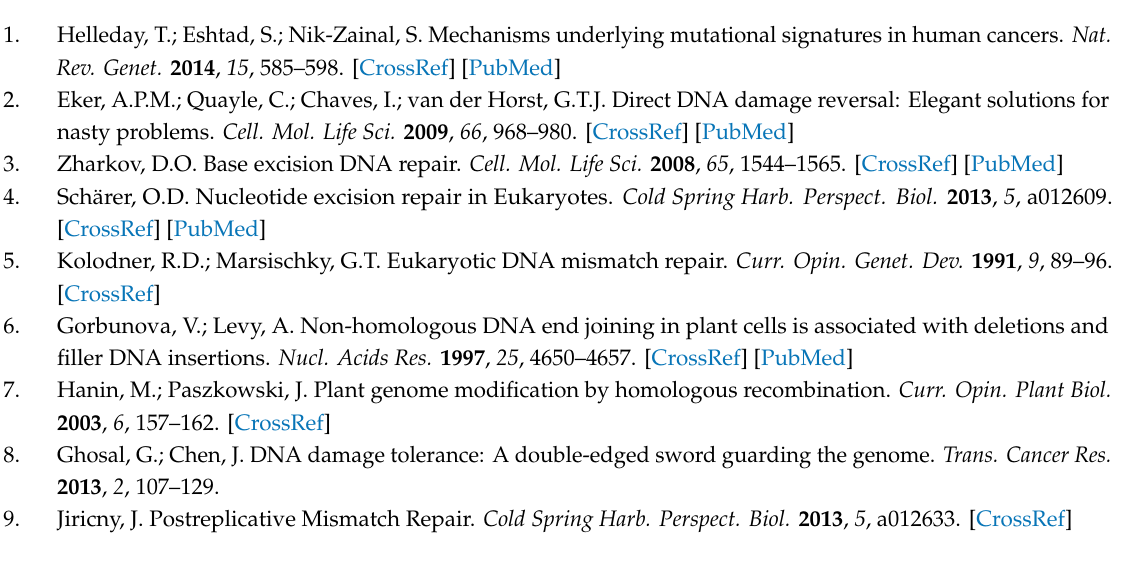
DMC1: wheat. Figure S6: MSH5 interactions. Single MSH5 is shown on the left in purple and interaction is on the right. Interactions from top to bottom: MLH1: yellow; MLH3: red; PCNA1: red; PCNA2: orange; PMS: cyan; RECQ4A: red; RECQ4B: blue; RECQl1: green; RECQl3: orange; RECQSIM: yellow. Figure S7: MSH6 interactions. Single MSH6 is shown on the left in purple and interaction is on the right. Interactions from top to bottom: MLH1: red; MLH3: green; MSH2: yellow; MSH5: orange; PCNA1: blue; PCNA2: turquoise; PMS1: cyan; RECQSIM: beige; TIL1: orange; TIL2: orange. Figure S8: MSH7 interactions. Single MSH7 is shown on the left in purple and interaction is on the right. Interactions from top to bottom: MLH1: red; MLH3: green; MSH2: orange; MSH5: blue; PCNA1: green; PCNA2: orange; PMS1: cyan; RECQSIM: blue; TIL1: green; TIL2: gray. Figure S9: STRING Interactome of AtMSHs. (A) MSH1; (B) MSH2; (C) MSH3; (D) MSH4; (E) MSH5; (F) MSH6; (G) MSH7. Table S1: Docking sites of protein–protein interactions; MSH homologs and their